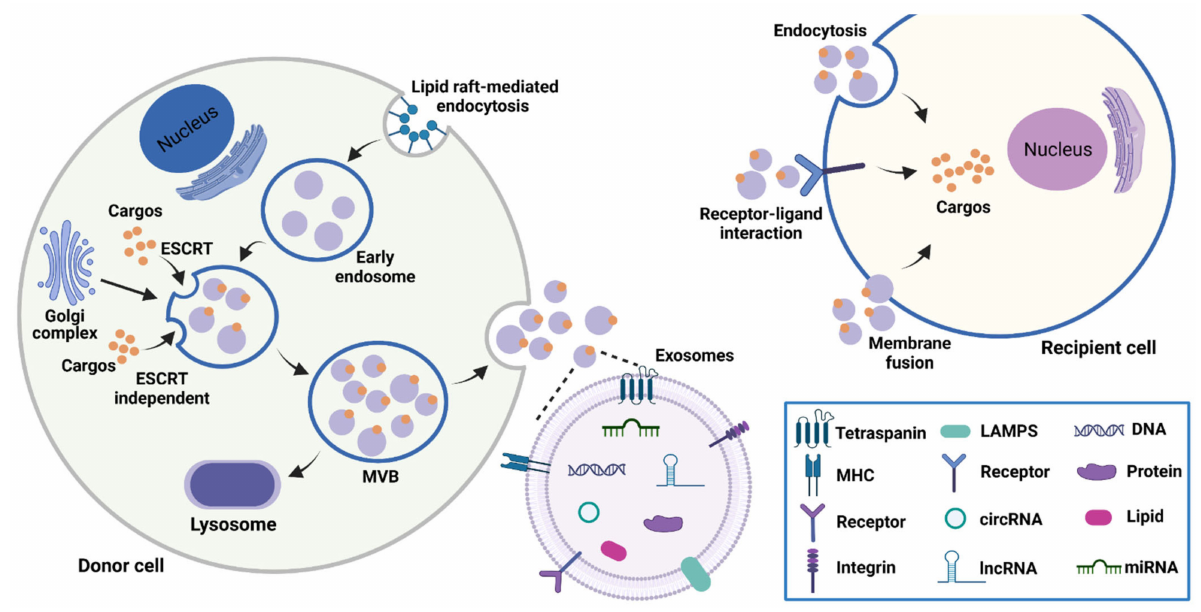
Figure 1. The biogenesis, contents, and uptake of exosomes. Exosomes are derived from the fusion of MVBs with plasma membranes. Exosomes transport cargos including nucleic acids, proteins, and lipids to recipient cells mainly through membrane fusion, receptor-ligand interaction, and